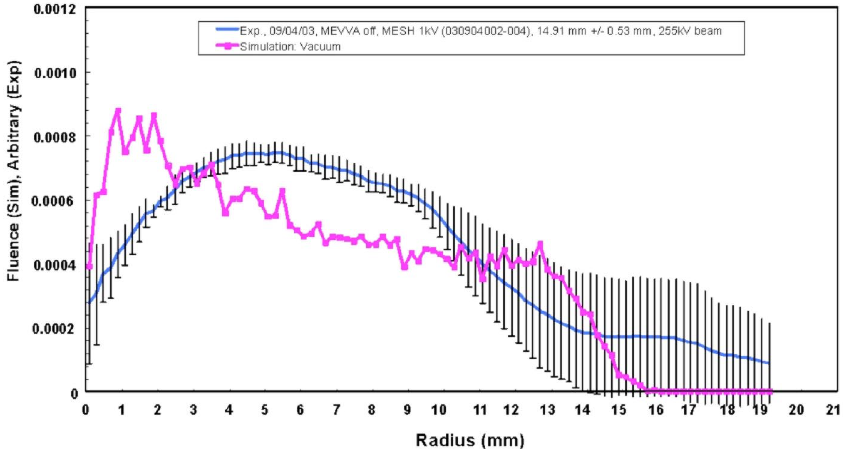
FIG. 39. (Color) Comparison of a radial density profile from an unneutralized NTX shot with a theoretical profile (magenta) from an LSP